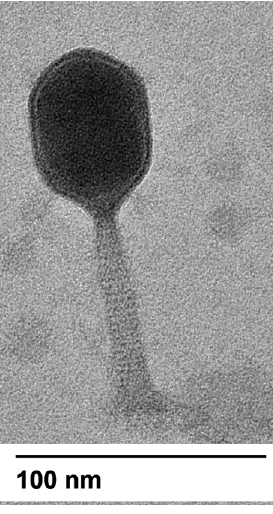
Figure 2. Electron micrograph of APTC-EC-2A. Transmission electron micrograph of E. coli APTC- EC-2A phage, belonging to the Myoviridae family. Scale bar represents 100 nm.